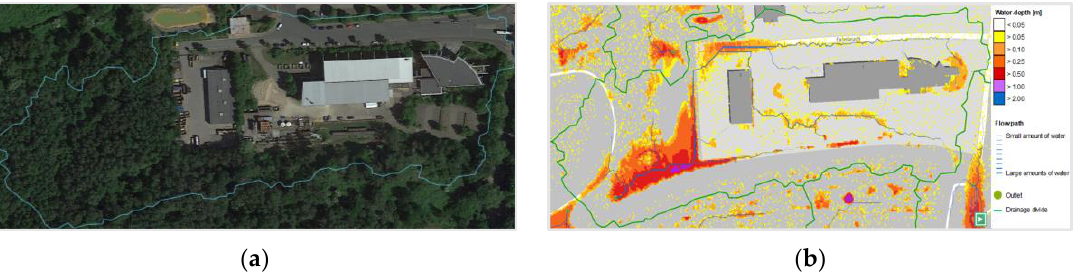
Figure 2. Study area: ( a ) Google Maps view [33]; ( b ) official flood map provided by the city of Gelsenkirchen [30].